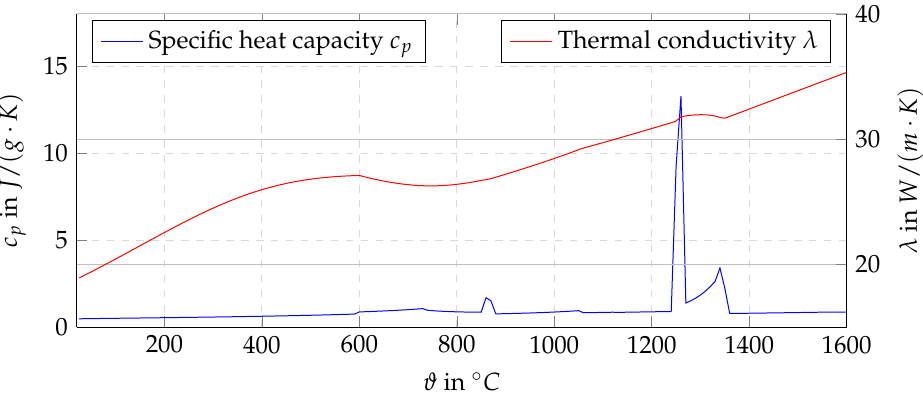
Figure 4. Calculated specific heat capacity and thermal conductivity of the substrate material Elmax in dependence on temperature.